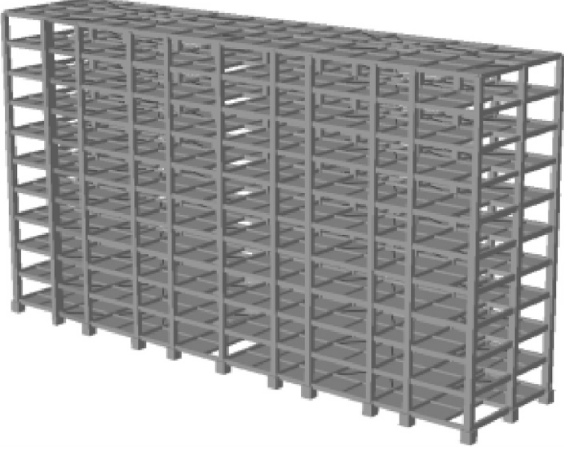
Figure 9: 3D diagram of